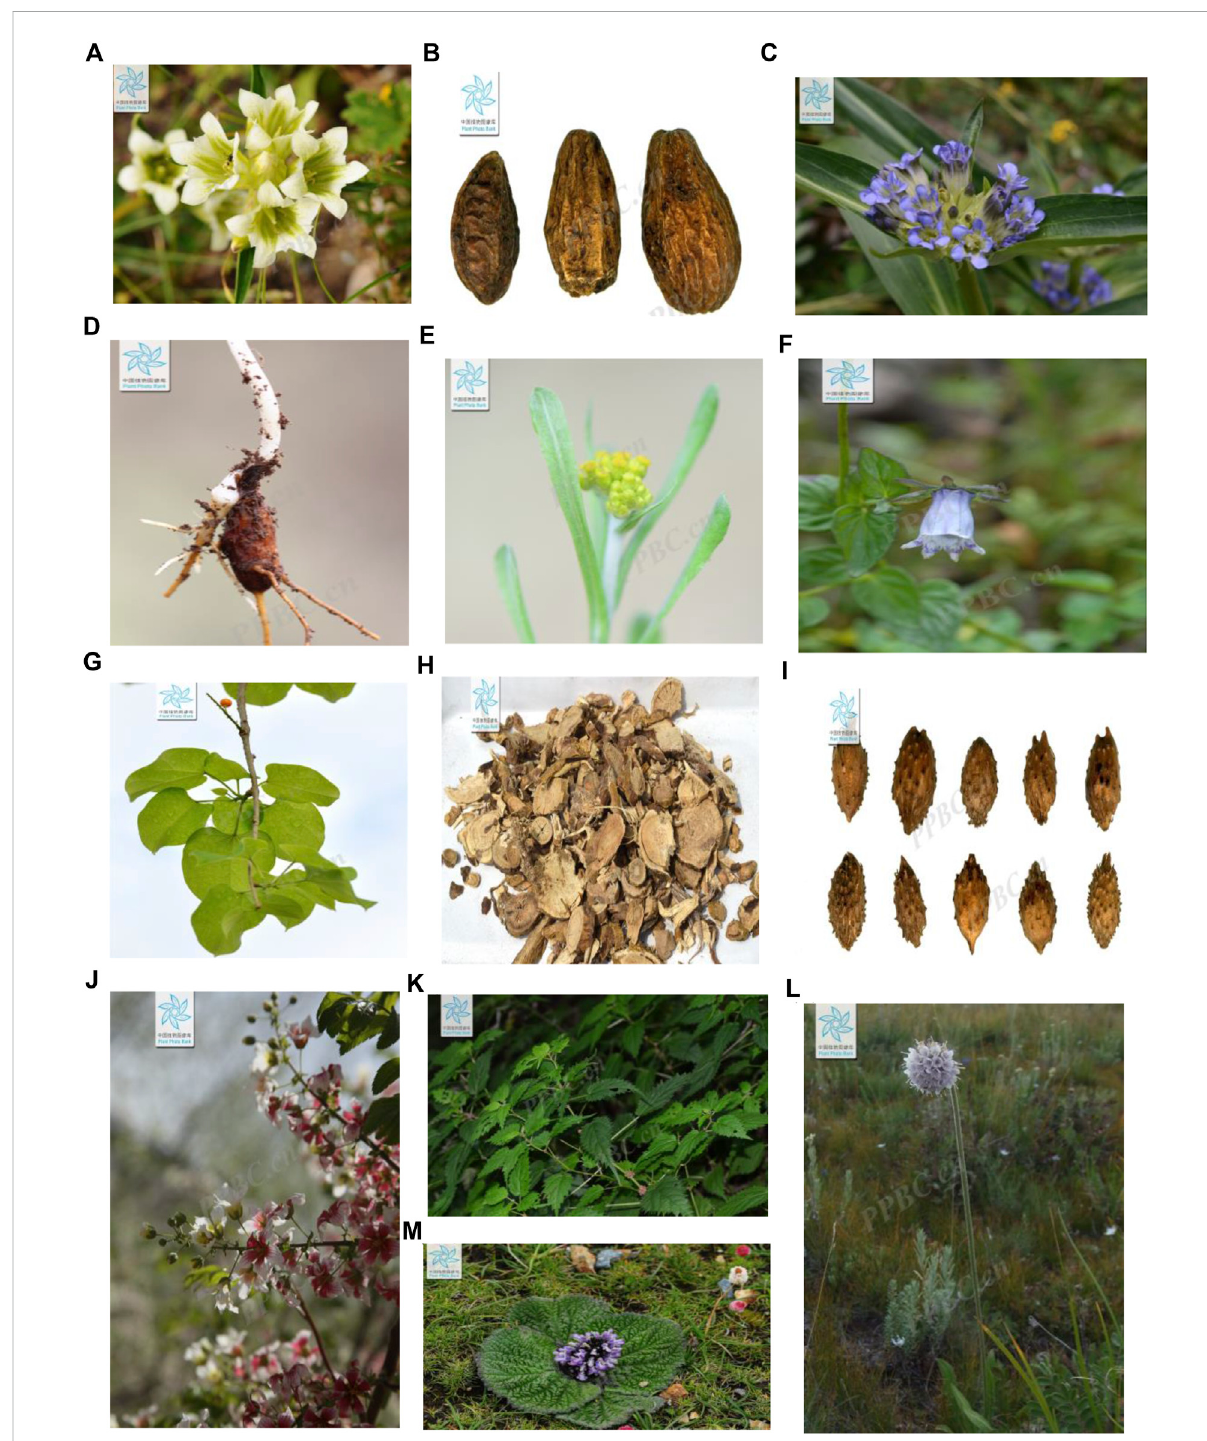
FIGURE 2 Tibetan medicines are commonly used to treat rheumatism (all the images are collected from the Flora of China, http://ppbc.iplant.cn) (A) . (G) Maxim. (B) . T.chehula Retz (C) . G.macrophylla Pall. (D) . A.pendulum Busch (E) . P.af fi ne (D.Don)Anderberg (F) . C.thalictrifolia